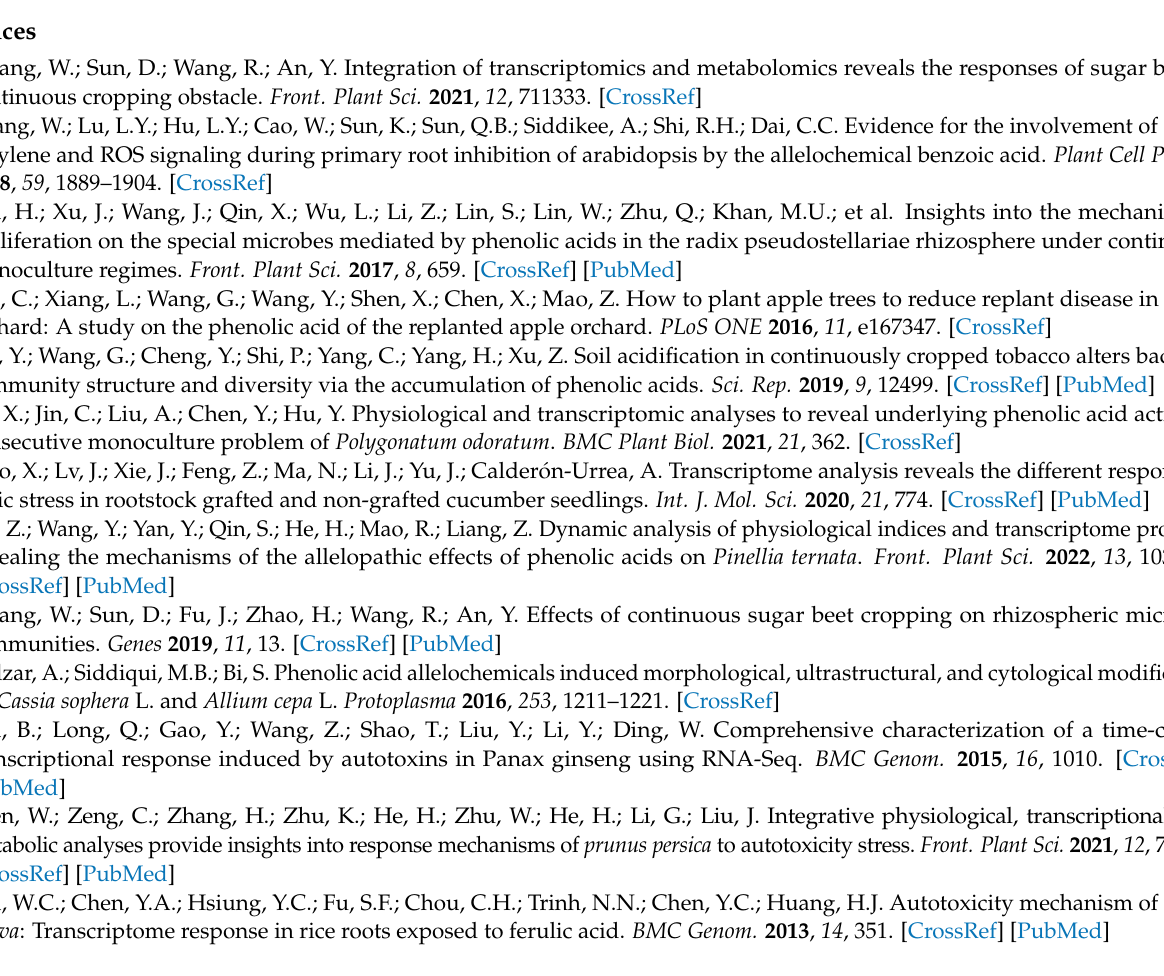
top 20 KEGG pathways for 863 down-regulated DEGs in response to the p -CA stress ( B ), and 159 up-regulated ( C ) and 259 down-regulated ( D ) DEGs specifically regulated by the BDO composite particles. Table S1. Effect of different p -coumaric acid concentrations on the germination of tomato seeds. Table S2. Specific primers were used for q-PCR. Table S3. Effects of various treatments on the tomato seed germination